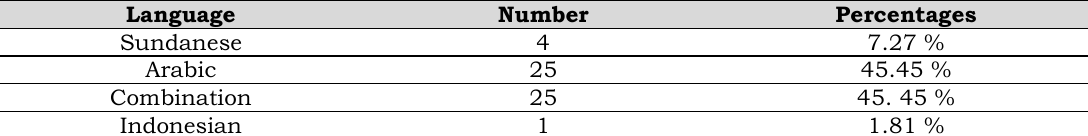
Table 1. The percentage of children name based on its language origin Language